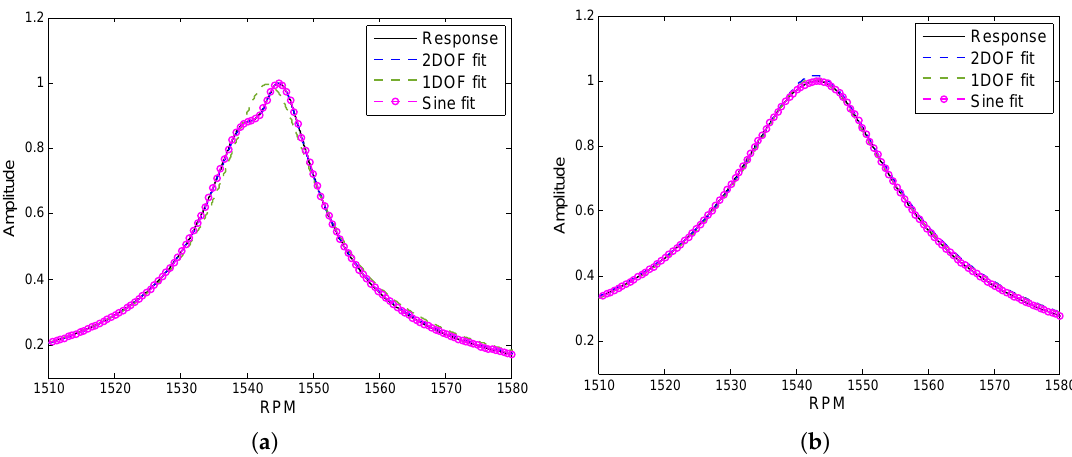
Figure 12. Comparison of non-dimensional amplitudes obtained by different fitting methods for SD = 0.10, ( a ) EO = 10, ζ 1,2 = 0.003, ( b ) EO = 10, ζ 1,2 = 0.006.